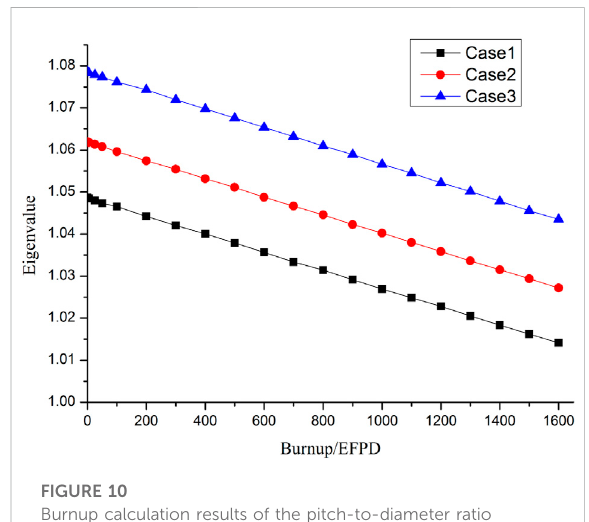
FIGURE 10 Burnup calculation results of the pitch-to-diameter ratio analysis.